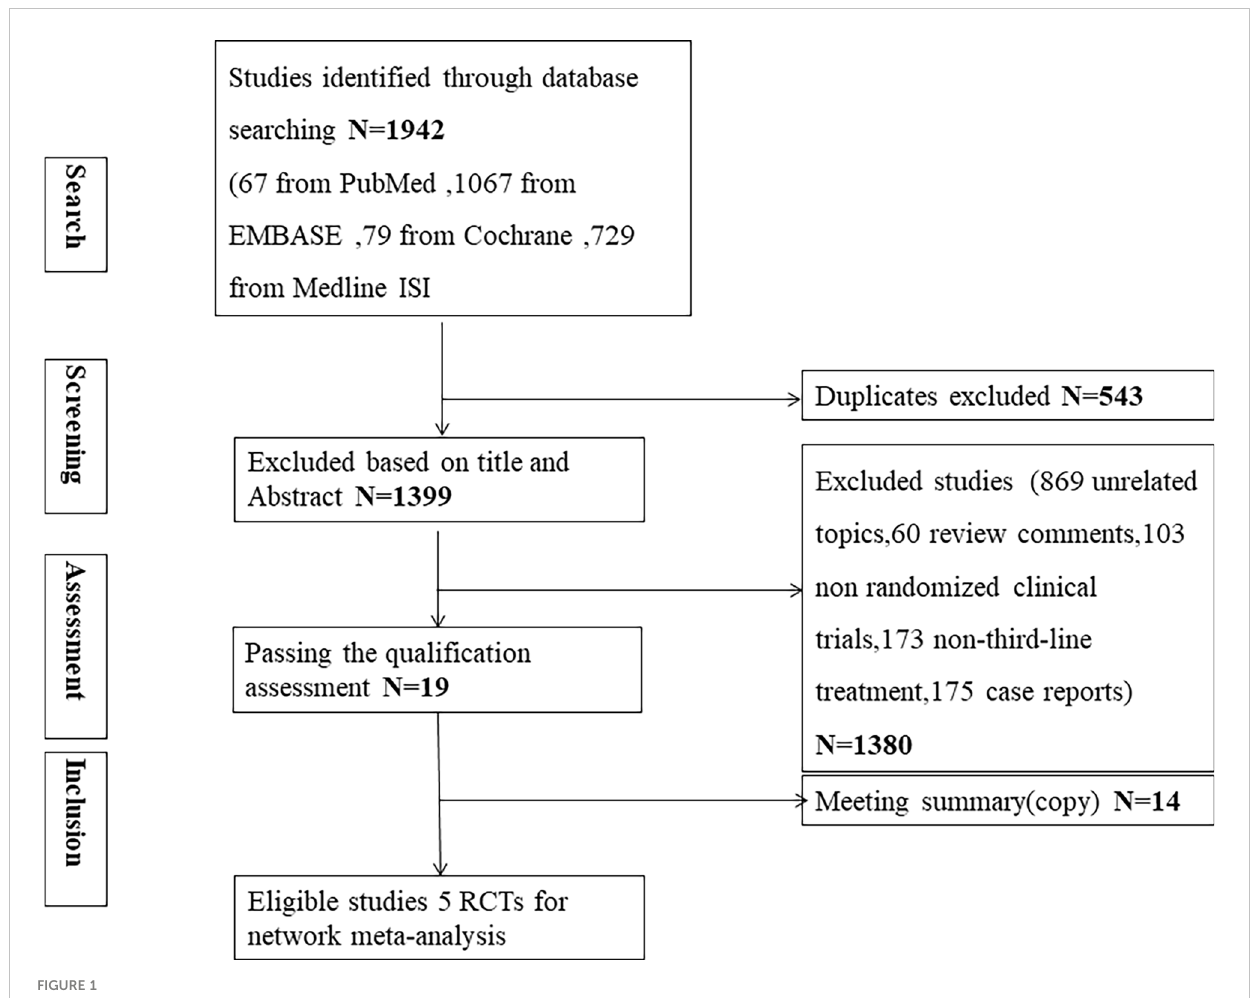
0.22-0.66) and DS-8201 (HR: 0.45, 95% CI: 0.23-0.89) achieved signi fi cant OS bene fi ts in patients who were HER2-positive compared to placebo. Furthermore, DS-8201 (HR: 0.59, 95% CI: 0.39-0.88) signi fi cantly prolonged the OS of patients compared with chemotherapy (Figure 3C). The SUCRA values of DS-8201 (0.85) and nivolumab (0.8) were signi fi cantly higher than that of chemotherapy (0.29) in HER2-positive patients (Supplementary Figure 1). For patients with HER2 IHC2+/FISH- or IHC1+, the OS of placebo was shorter than that of nivolumab (HR: 1.41, 95% CI: 1.14-1.75) and chemotherapy (HR: 1.61, 95% CI: 1.23-2.1). However, the SUCRA value of nivolumab (0.61) was still higher than that of chemotherapy (0.39). Because Destiny-Gastronomy 01 (2020) (12) did not document the HR values of patients who were HER2-positive (IHC2+/FISH-) and HER2-negative (IHC1+), we cannot further compare the relative ef fi cacy of DS-8201 with other treatments. However, the results of the exploratory cohort study of DS-8201 by DESTINY-Gastric01 showed that the mOS of HER2- positive, IHC2+/FISH-, and IHC1+ were 12.6 months (95% CI: 0.4- 33.2), 7.8 months (95% CI: 0.2-27.7) and 8.5 months(95% CI: 1.8- 23.1) respectively, all meeting the primary endpoint of